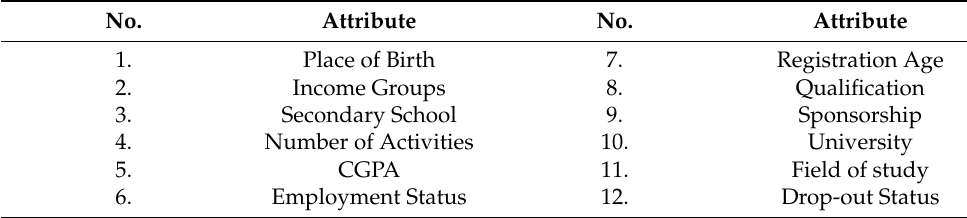
Table 6. Model C (MinMaxScaler and unsupervised feature